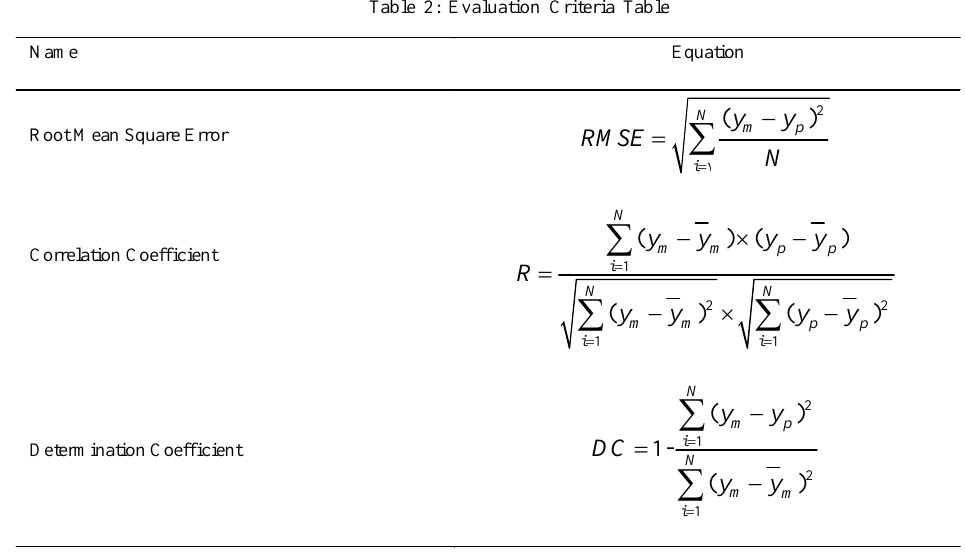
Table 2: Evaluation Criteria